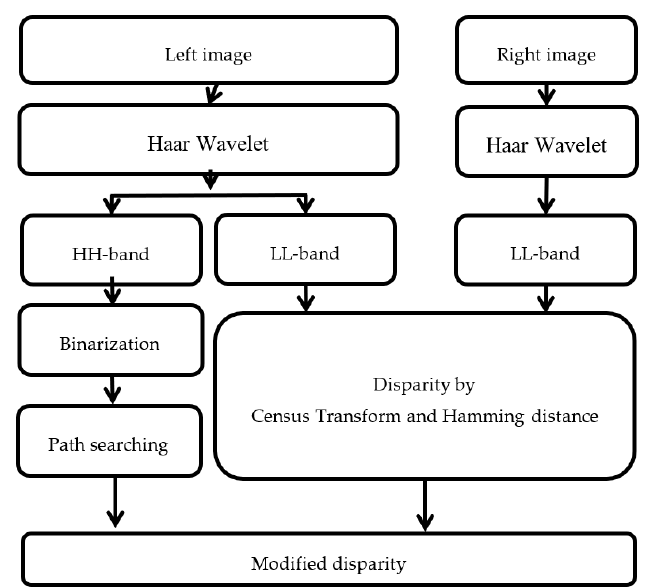
Figure 2. The flowchart of the census transform with Haar Wavelet.